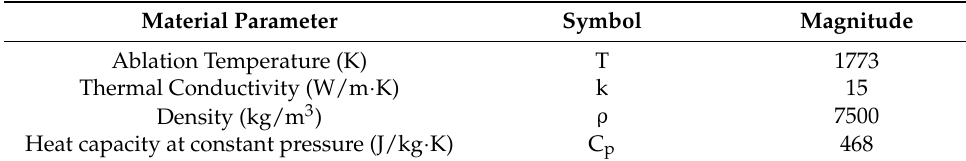
Figure 2. ( a ) Schematics of the Goldak double ellipsoid model and ( b ) meshed WAAM model. Table 3. Materials properties used for simulation.